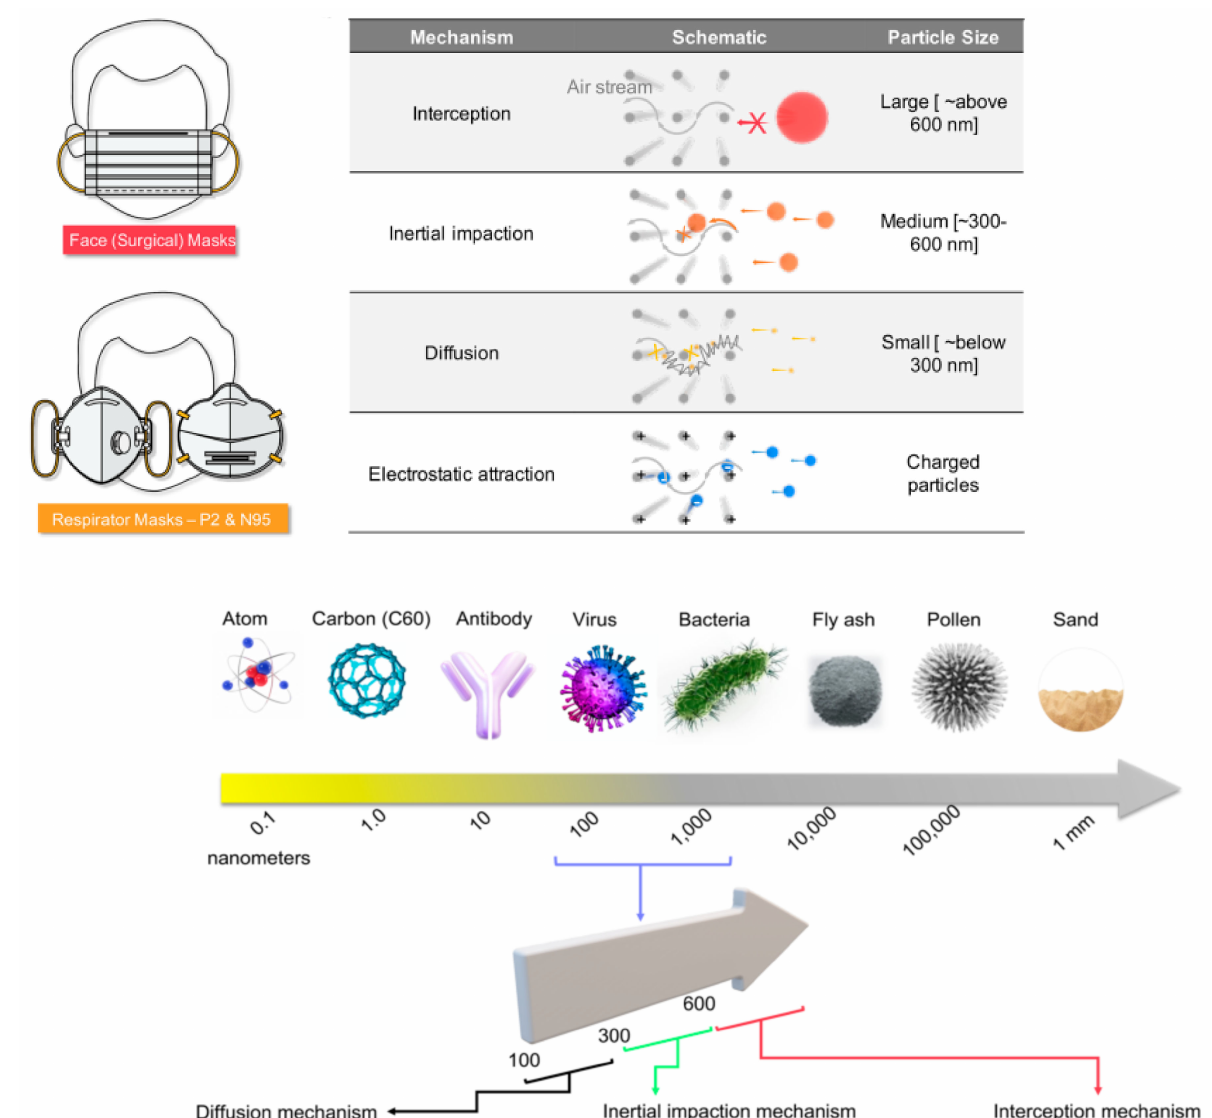
Figure 5. Various types of protective masks